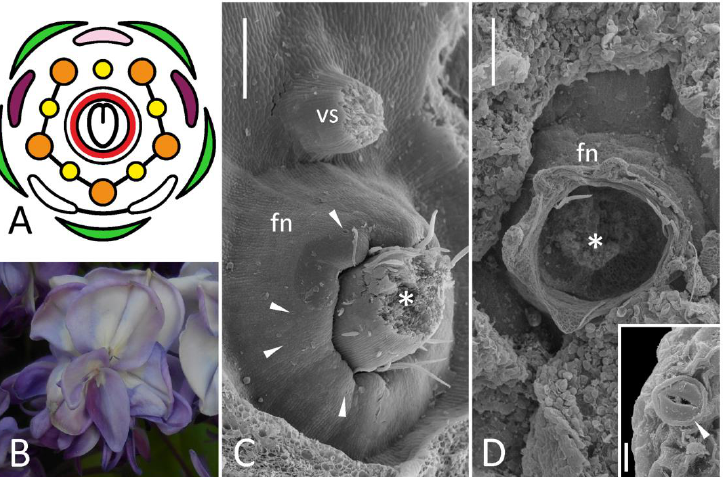
Figure 3. Floral diagram ( A ) and position of FN ( C ) of wild-type flower of Wisteria sinensis compared with an overall morphology ( B ) and position of FN ( D ) of ‘double’ flower of W. floribunda f. violaceoplena . Key: arrowheads = exemplary nectariferous stomata (enlarged in inset of ( D ); asterisk = carpel base or place where it was attached; fn = floral nectary; vs = vexillary stamen. For color designations on floral diagram, see Figure 1. Scale bars: 300 μm ( C , D ), 10 μm ( D , inset).